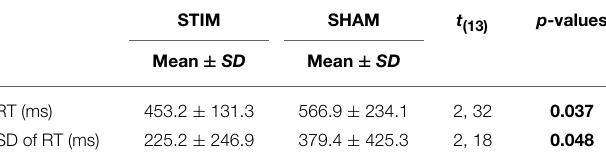
TABLE 3 | Results of the control tasks “Alertness” and “Motor memory.”